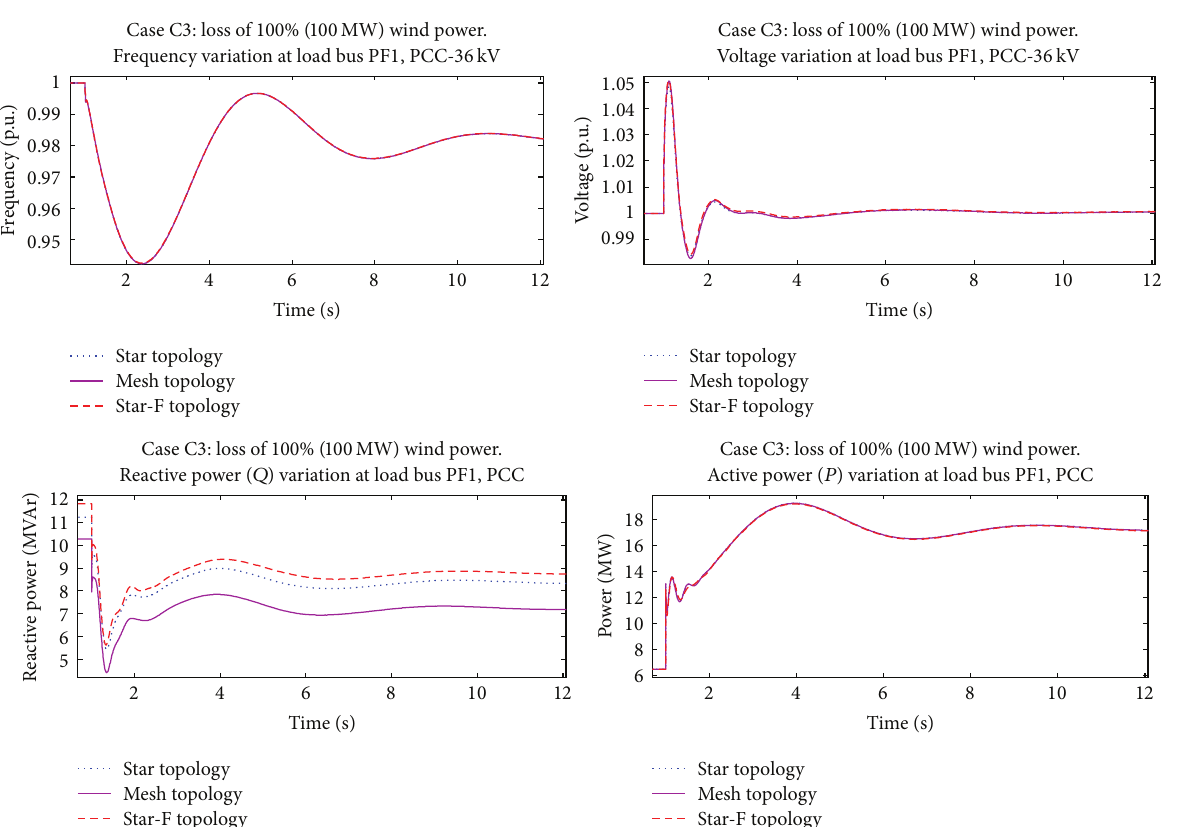
Figure 10: Frequency, voltage, and power variations due to loss of 100% wind